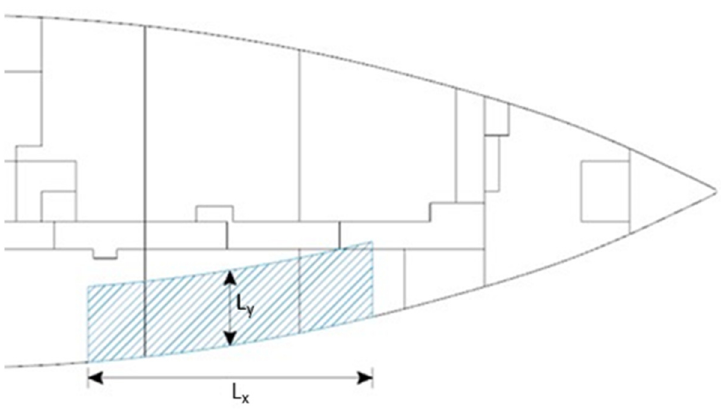
Figure 1. Breach definition along the ship side.